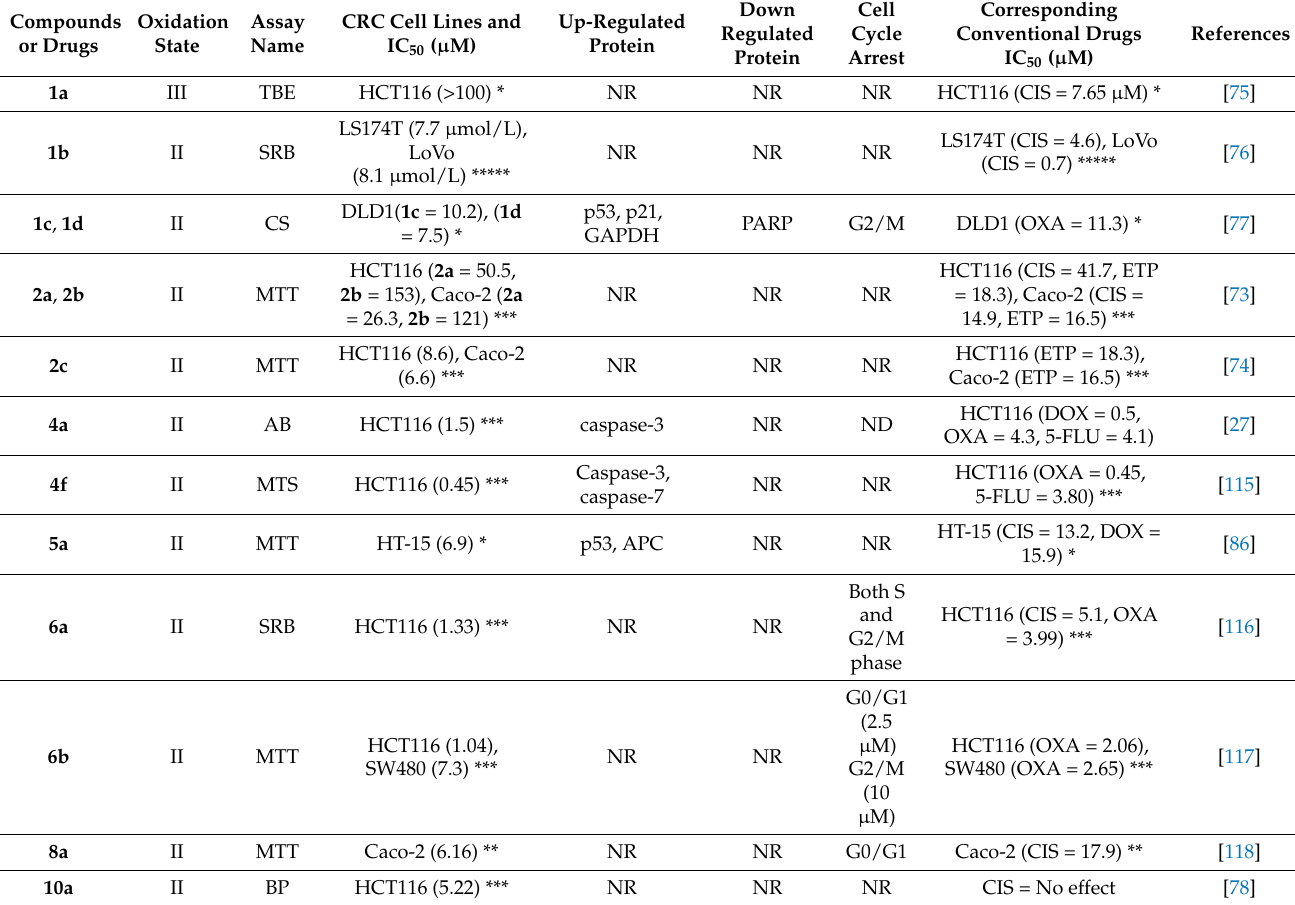
Table 1. Potency of Ru-based drug candidate(s) compared to conventional anticancer drugs. Compounds Oxidation or Drugs